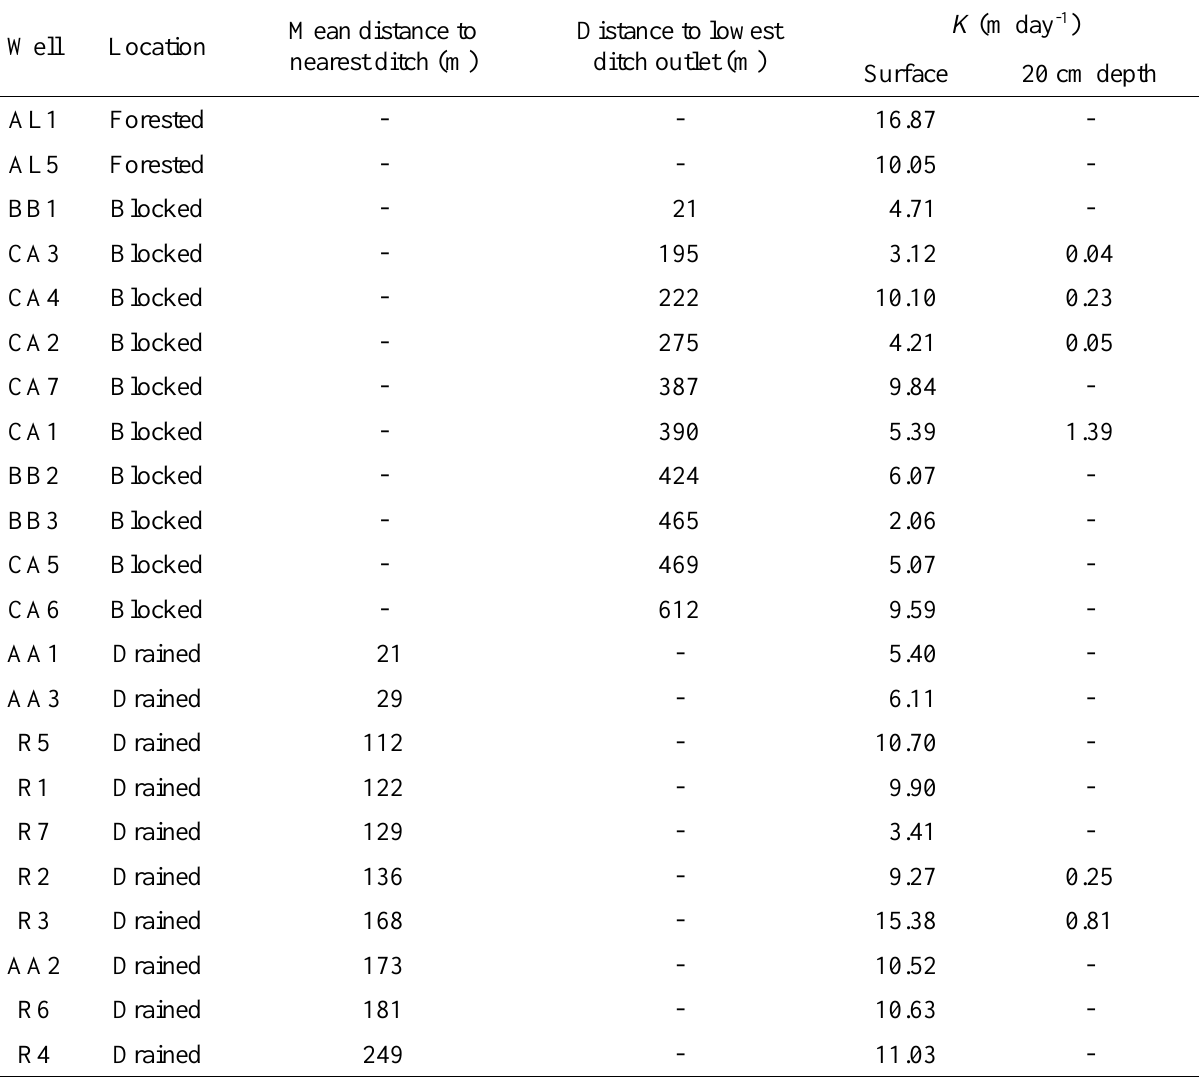
Table 4. Near-surface saturated hydraulic conductivity ( K ) for the studied wells.